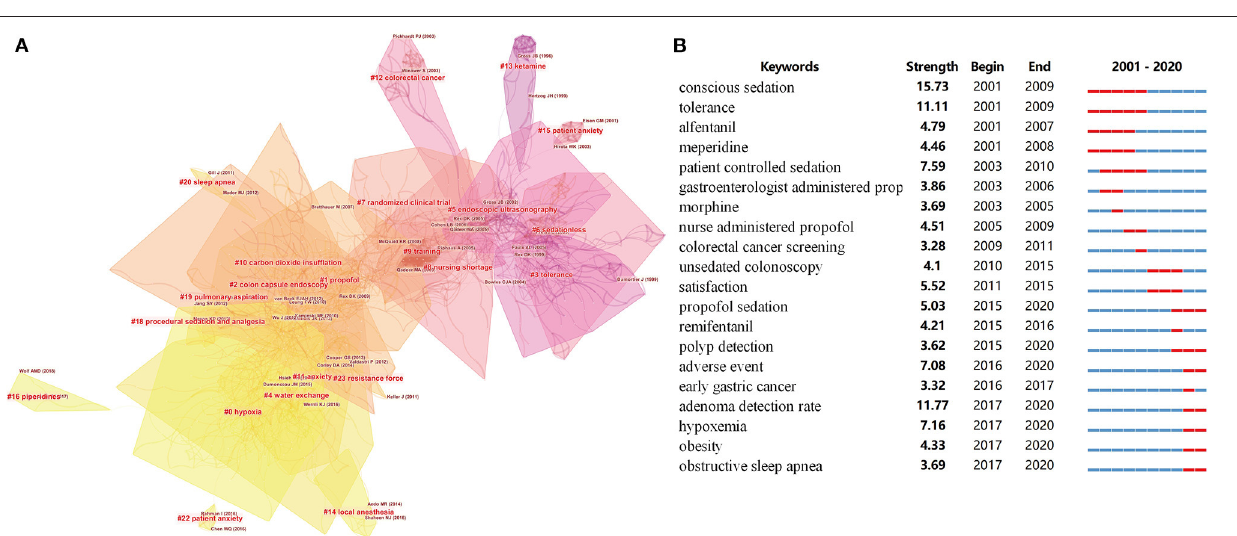
used benzodiazepines are midazolam and diazepam. The most commonly used opioids are pethidine and fentanyl